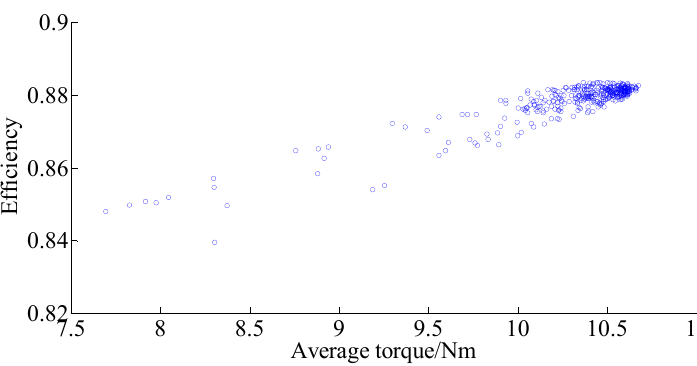
Figure 3. Optimization results of average torque and efficiency.